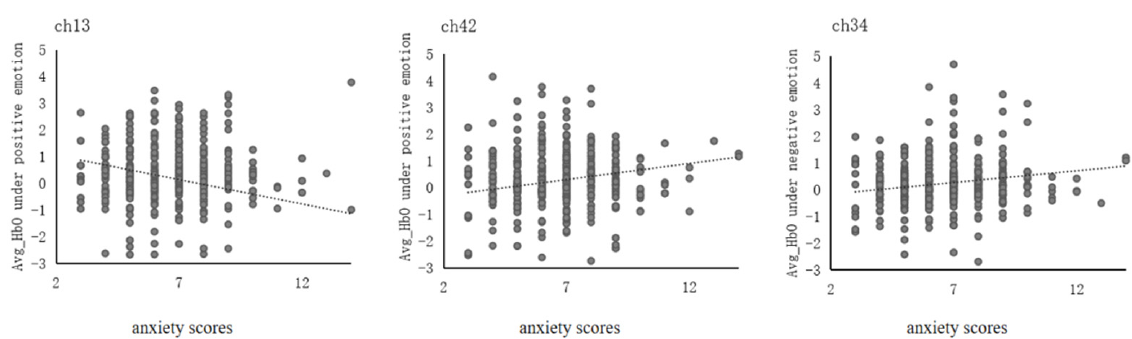
Figure 5. Correlation between the severity of anxiety and the average oxyhemoglobin under different emotions.